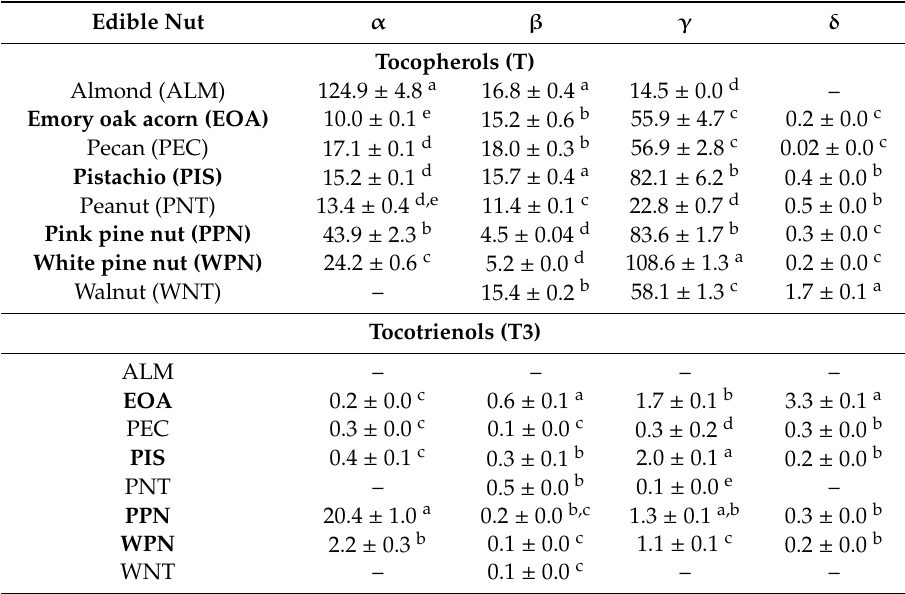
− 1 The amount of lipophilic phenolic compounds (mg GAE.100 g oil; Table 2) ranged from 3.3 (EOA) to 1219 (PPN), correlating with total fat (r = 0.93, p ≤ 0.0001), moisture ( − 0.60, p = 0.015), tocol (r = 0.62, p = 0.011), T (r = 0.58, p = 0.019), protein (r = − 0.59, p = 0.016) and total carbohydrates (r = − 0.55, p = 0.026; Supplementary Table Table 2. Phenolic compounds and carotenoids in edible nuts 1 .